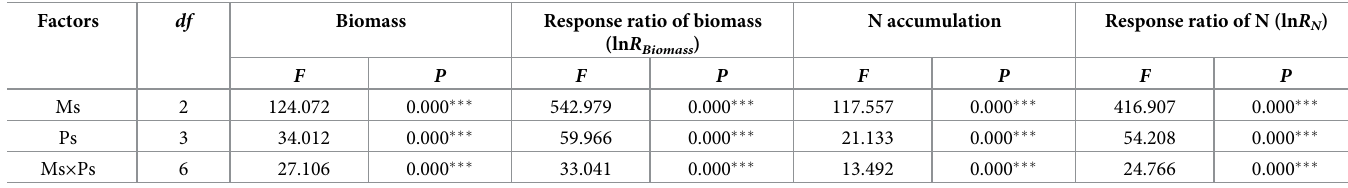
Abbreviations: Ms = Soil microbial condition treatments; Ps = Plant species;